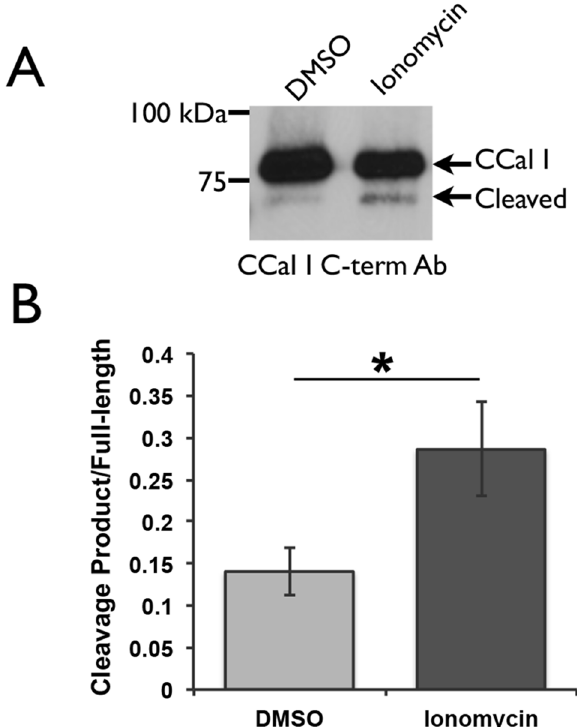
Fig 8. AplCCal1 autolyses in vivo . (A) Desheathedpairedpleural-pedal gangliawere treated for 20min with 100uMionomycinor vehicleand then homogenized and subjectedto western blot with an antibodyagainst the C-terminal of AplCCal1. (B) Quantification of data from 4 independentexperiments as shown in (A). A one-tailedt-test for pairedsamples yieldedp < 0.05,represented by an asterisk ( * ). Error bars show SEM.